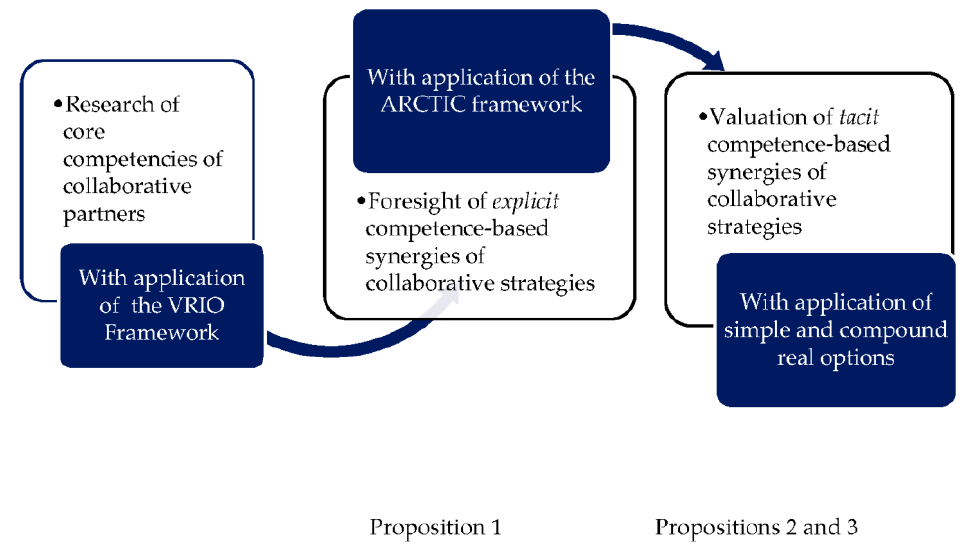
Figure 1. The relationship between the developed propositions: The conceptual model of foresight of explicit synergies and valuation of tacit competence-based synergies. Source: Developed by the author.